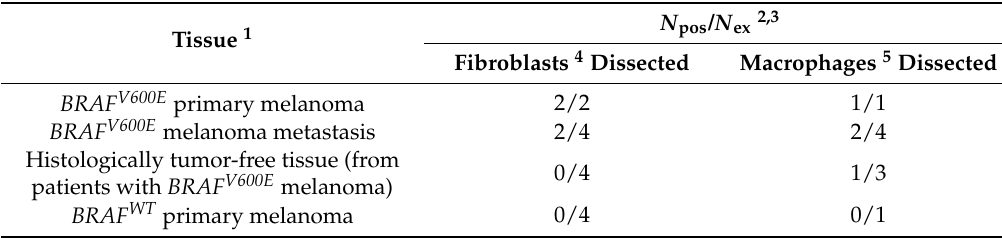
Figure 1. Peritumoral stromal cells express the melanoma-derived oncogenic BRAF V600E protein. ( a , b ) Tissue samples of a patient with BRAF V600E melanoma stained for the melanoma marker melanoma antigen recognized by T-cells (MART1) (red), the BRAF V600E mutant protein (brown) and hematoxylin (blue). Brown arrows indicate peritumoral MART1 − /BRAF V600E + cells displaying fibroblast ( a ) or macrophage ( b ) morphology. Blue arrows indicate MART1 − /BRAF V600E − stromal cells (light blue from hematoxylin). Red lines indicate MART1+ melanoma cells. Black bars indicate 50 µm. Table 1. Peritumoral fibroblasts and macrophages in BRAF V600E melanoma carry the melanoma-derived BRAF V600E mutation at the genetic level.